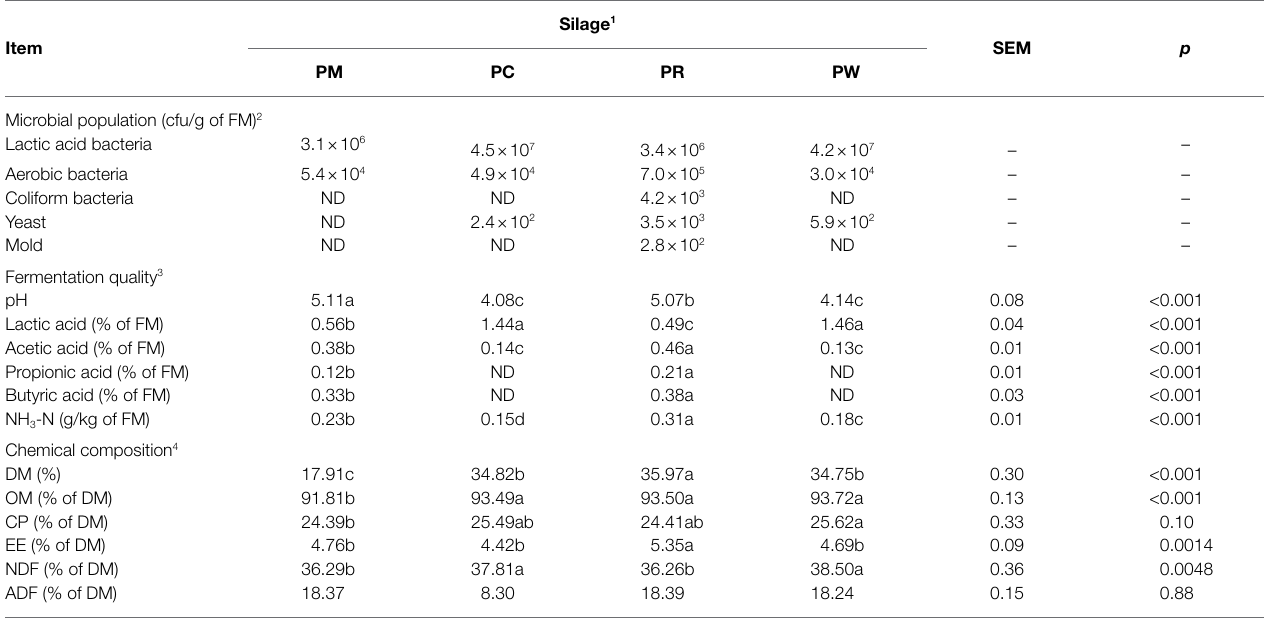
TABLE 2 | Microbial population, fermentation quality, and chemical composition of silage.